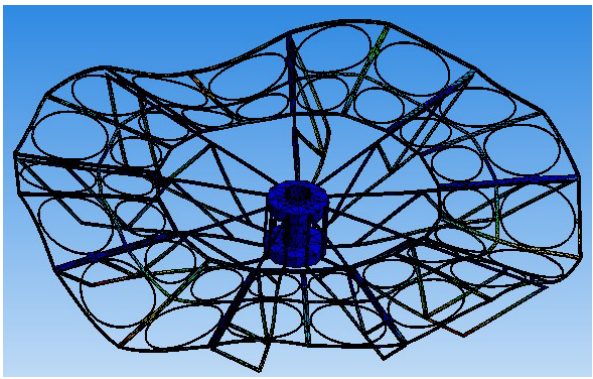
Figure 11. Fourth-order mode shape of free vibration.